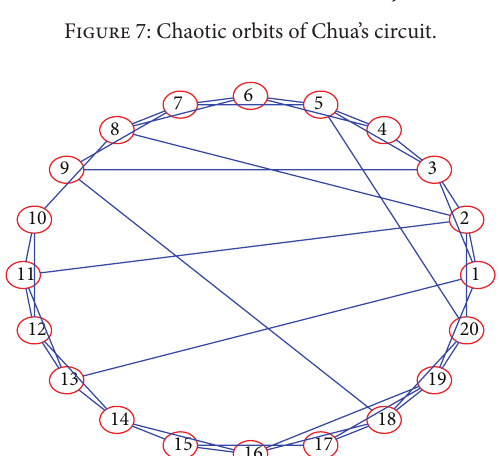
Figure 8: Connection of the complex network system.